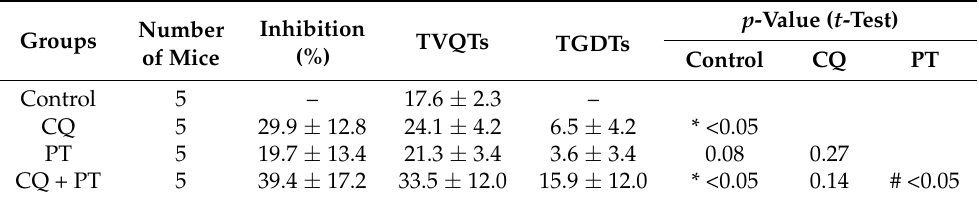
Table 1. Comparison of tumor growth inhibition, tumor volume quadrupling times, and tumor